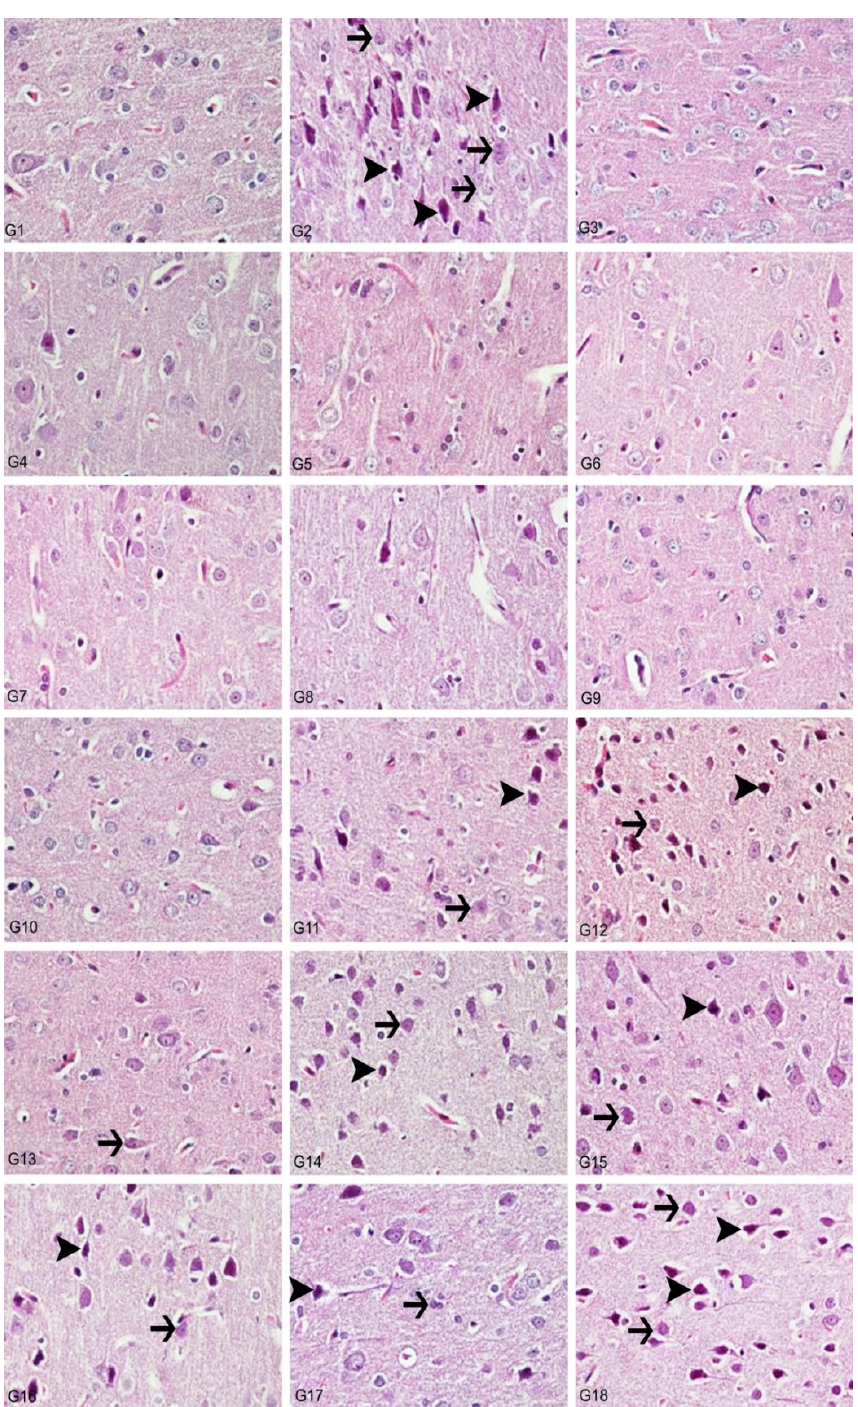
Figure 9. Cerebral cortex, degeneration of neurons (arrows), necrosis (arrowheads), hyperemia, H&E, 40X. (1) Control group, (2) Al-treated group for 30 days (as AlCl 3 , 4.2 mg/kg b.w.), (3) BA-treated group for 30 days (3.25 mg/kg b.w.), (4) BA-treated group for 30 days (6.5 mg/kg b.w.), (5) BX-treated group for 30 days (3.25 mg/kg b.w.), (6) BX-treated group for 30 days (6.5 mg/kg b.w.), (7) Col-treated group for 30 days (3.25 mg/kg b.w.), (8) Col-treated group for 30 days (6.5 mg/kg b.w.), (9) UX-treated group for 30 days (3.25 mg/kg b.w.), (10) UX-treated group for 30 days (6.5 mg/kg b.w.), (11) co-application of 3.25 mg/kg BA and 4.2 mg/kg Al, (12) co-application of 6.5 mg/kg BA and 4.2 mg/kg Al, (13) co-application of 3.25 mg/kg BX and 4.2 mg/kg Al, (14) co-application of